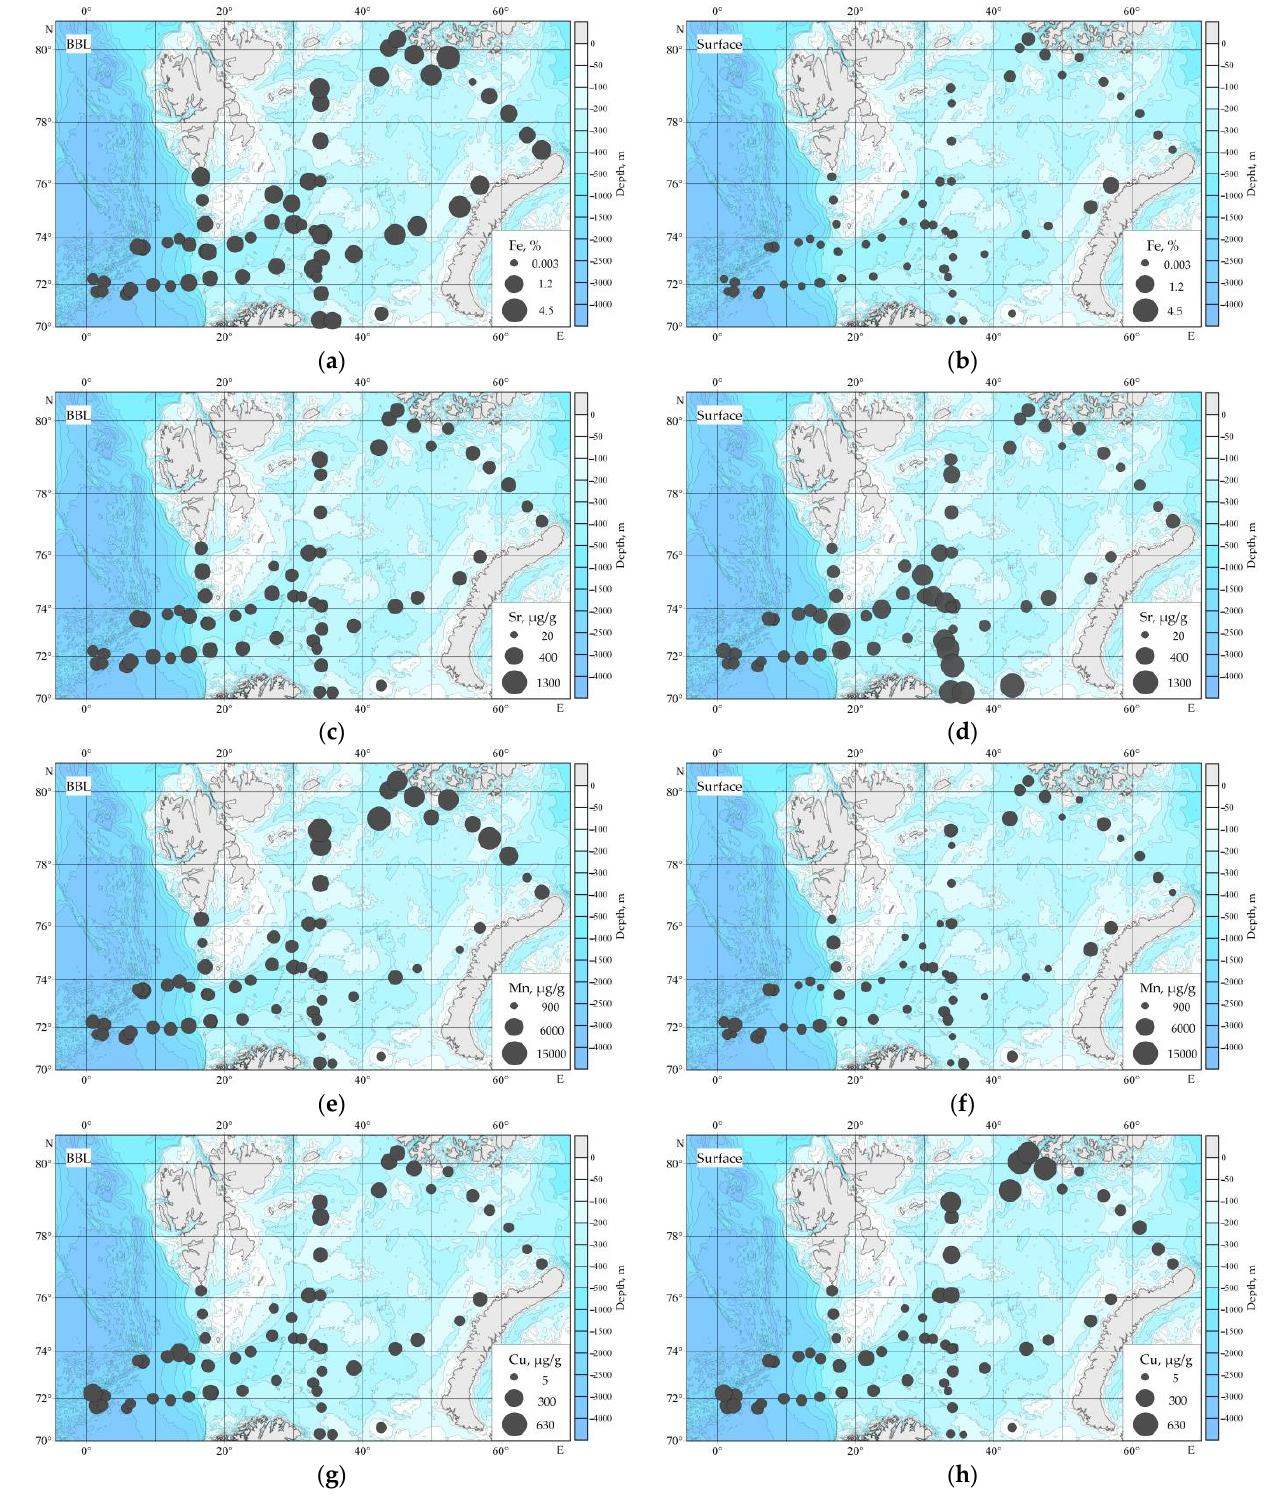
Figure 3. Spatial distribution of TEs: Fe ( a , b ); Sr ( c , d ); Mn ( e , f ); Cu ( g , h ) in the SPM of the surface (2 – 10 m) layer and BBL.